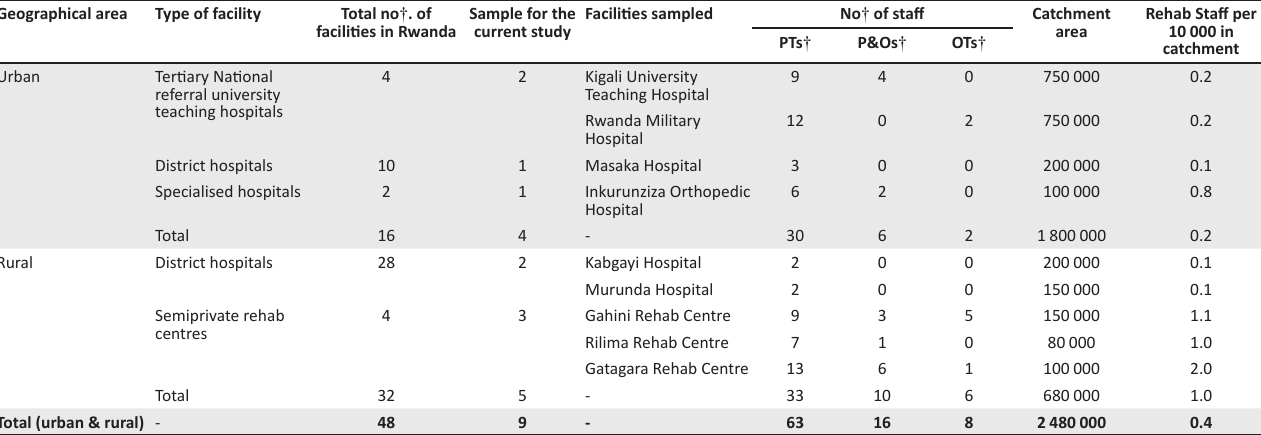
TABLE 1b: Distribution of rehabilitation services by geographical area and type of health facility. Geographical